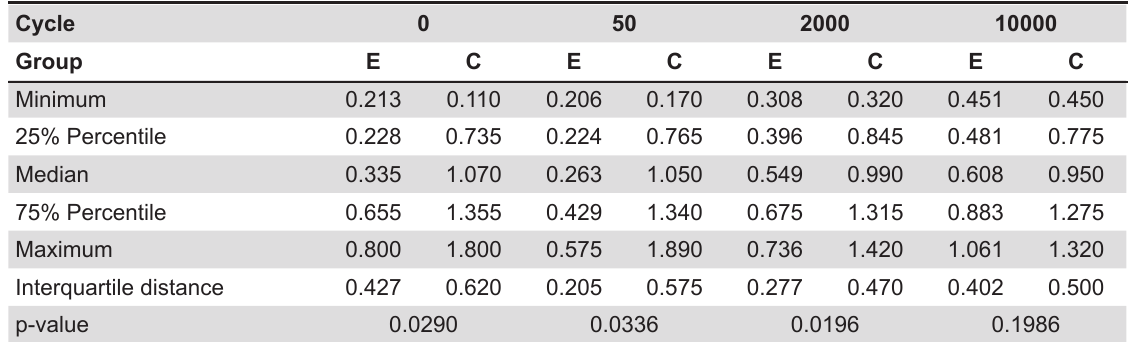
with 1.070 N/mm and an interquartile range of 0.620 N/mm. This ratio existed up to cycle 10000 with a median of 0.608 N/mm for group e and 0.950 N/mm for group C although the statistical test could only reveal significant difference for cycle 0, 50 and 2,000 (Table 2).